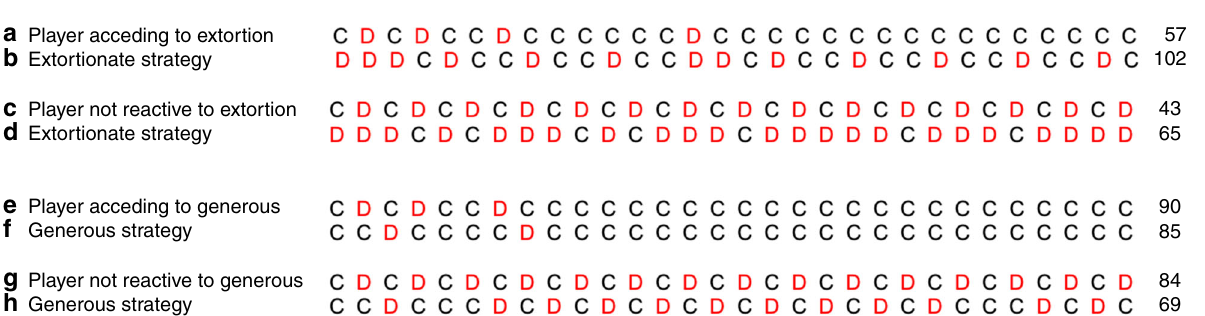
Fig. 1 Reactive and non-reactive players playing either C or D, paired with extortionate or generous. a A reactive player paired with b an extortionate strategy; c a non-reactive strategy paired with d an extortionate strategy; e a reactive strategy paired with f a generous strategy; g a non-reactive strategy paired with h a generous strategy; extortionate strategies do not cooperate in the fi rst round, they never cooperate after the partner ’ s defection, they cooperate after the partner ’ s cooperation with a probability of about 2/3. Generous strategies cooperate in the fi rst round, they always cooperate after the partner ’ s cooperation and they cooperate after the partner ’ s defection with a probability of about 0.1, values according to (16). A player earns most against an extortionate strategy by giving in to extortion, providing the extortioner with a much higher payoff ( a , b ). Extortioners outcompete their co-players. A player earns most against a generous strategy by giving in to generous; generous players let their co-players succeed until both have a similar gain ( e , f